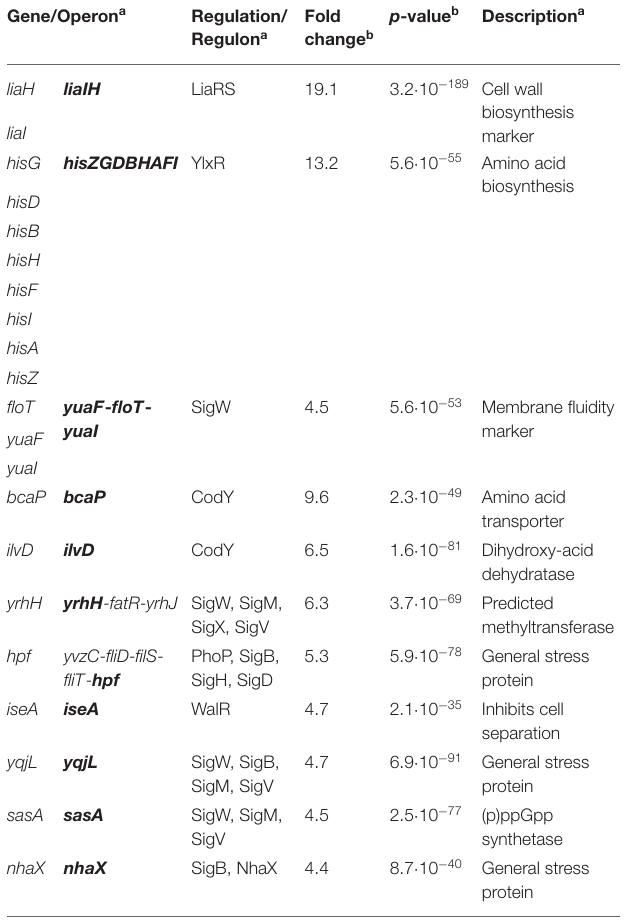
TABLE 1 | RNA-sequencing (RNA-seq) profile of B. subtilis upon YydF * treatment. Gene/Operon a